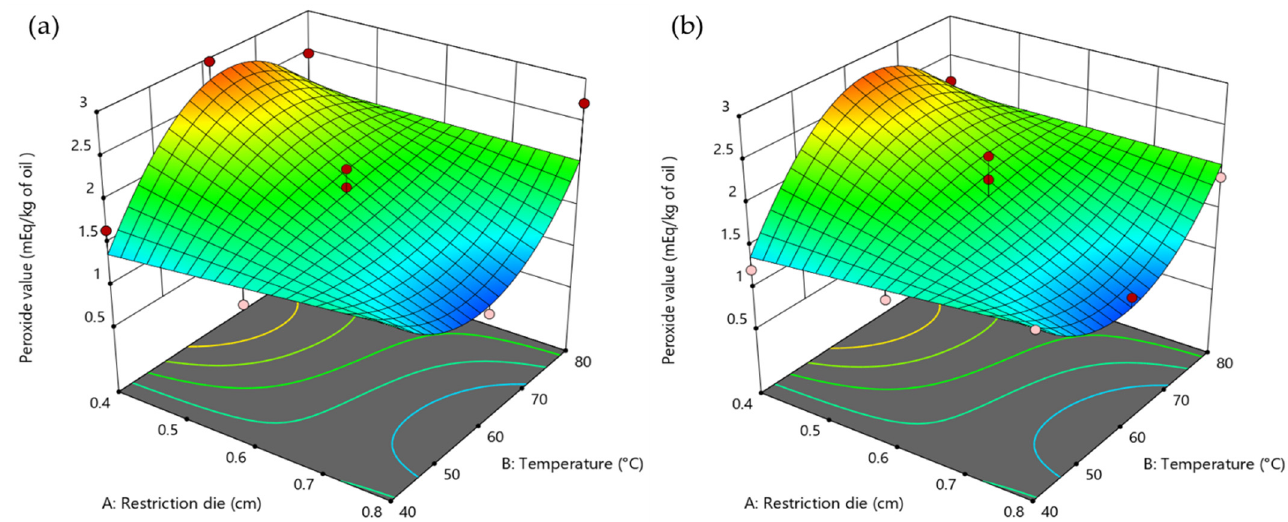
Figure 3. Response surface plot showing the effect of temperature and restriction die size on the peroxide value of CSO. ( a ) Sieve size: >1.4 mm, ( b ) Sieve size: <1.4 mm. Sieve size had no influence on the peroxide value of the